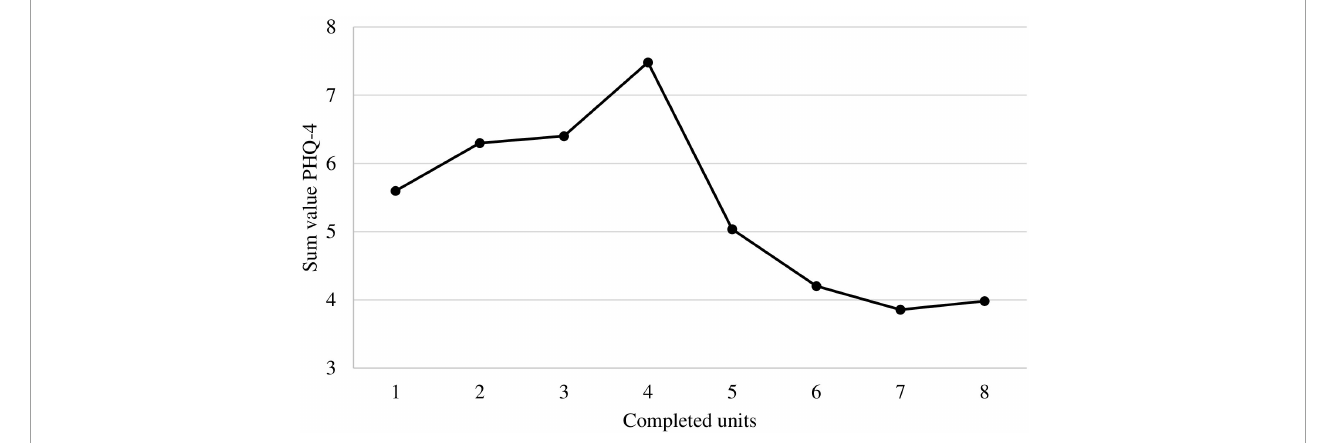
FIGURE2 Mean of the PHQ-4 in relation to program adherence (number of completed units). Note that the y-axis was cut to obtain more details on the